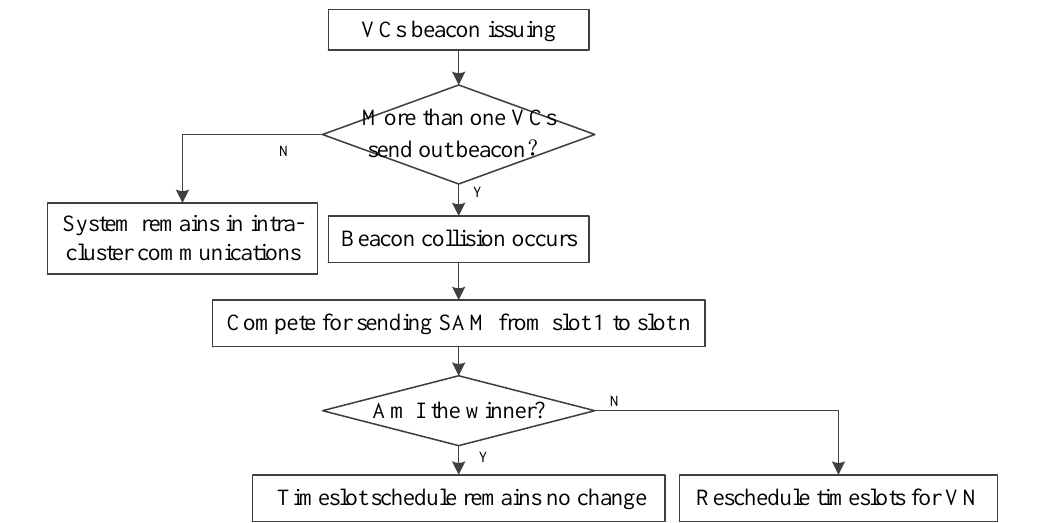
Figure 6. State transitions of inter-cluster communications in CBT.